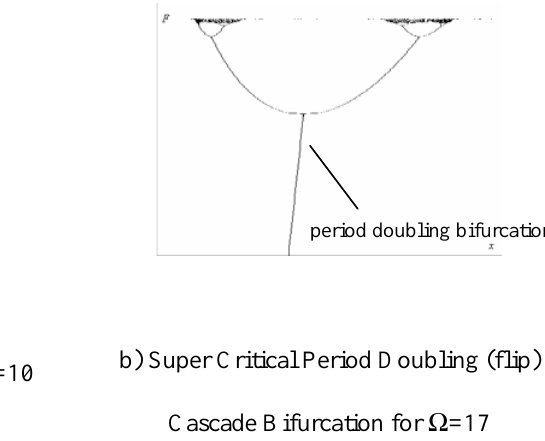
Fig. 6. The two possible escape mechanisms associated with the instability